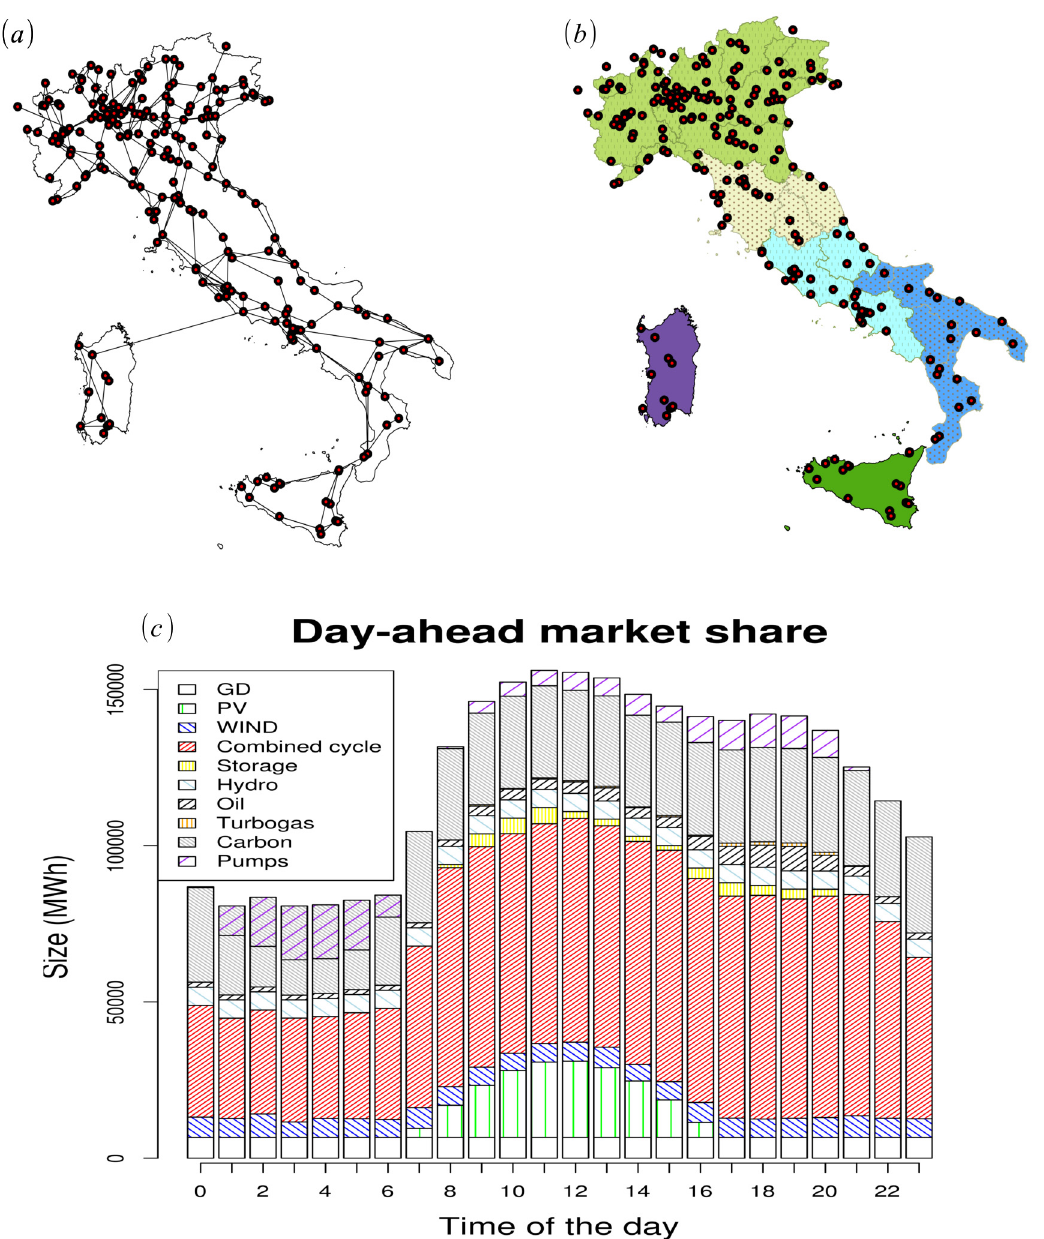
Fig 1. Input elements for evaluating the size of the balancing market (i.e. the short time fluctuations in power generation/demand). In panel (a) we show the electric transmission network in Italy; the topology and the physical characteristics of lines and generators are the constraints that influence the power flow. In panel (b) we show the market zone splitting used for managing the congestions of the entire Italian network. In panel (c) we show a typical ODA+ID market (One-Day-Ahead Market + Intraday Market) final output with the detailed contribution of each primary energy source; hence, it represent the day ahead energy needs as foreseen from energy operators. The balancing market takes care of short time fluctuations that occur during the day respect the scheduled ODA+ID output.